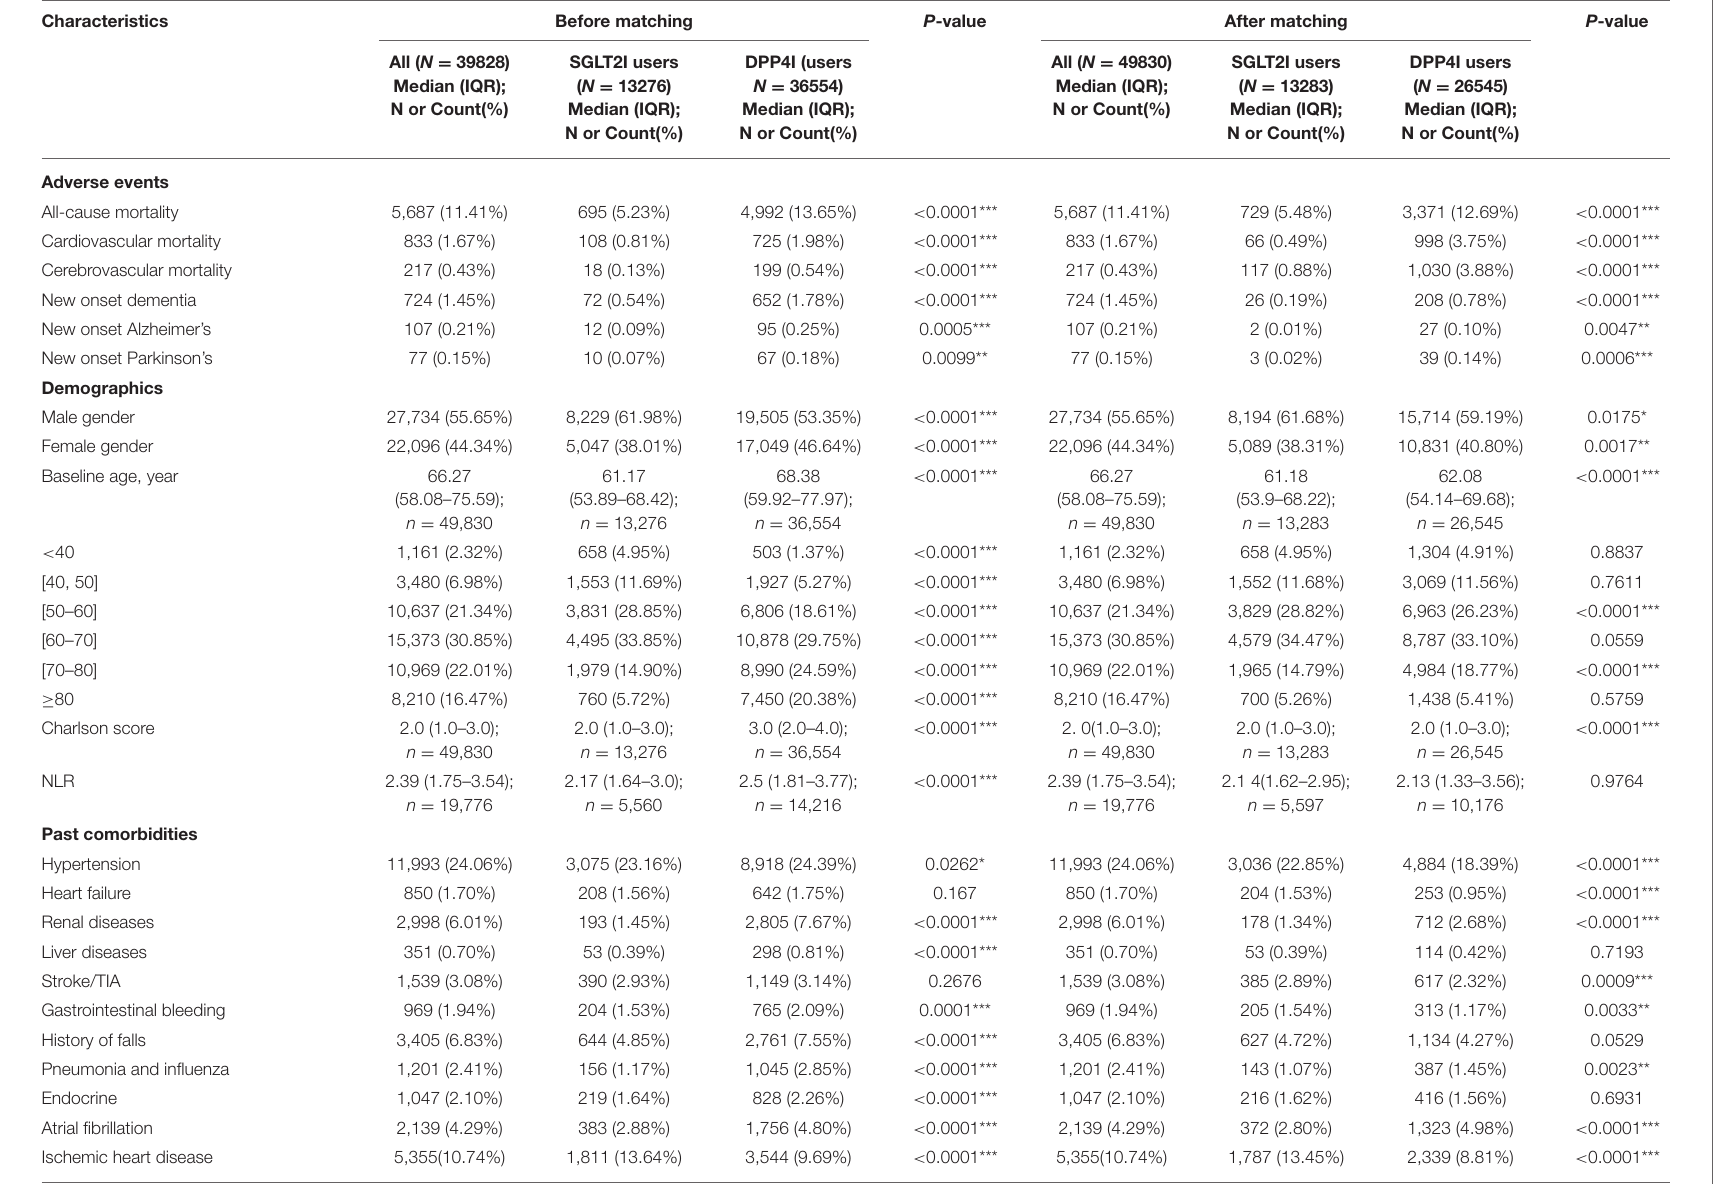
TABLE 1 | Baseline and clinical characteristics of patients with DPP4I vs. SGLT2I uses before and after propensity score matching (1:2).